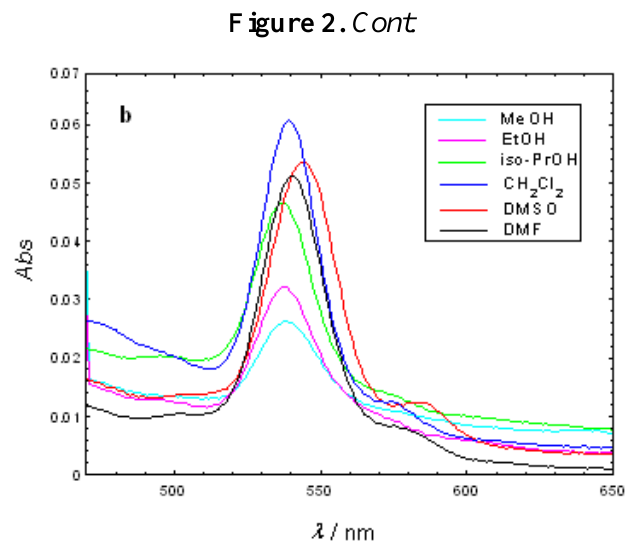
in different solvents ( a - m